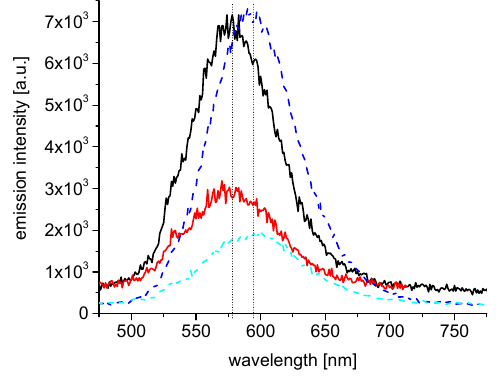
Figure 10. Temperature-dependent solubilization studies of the solvatochromic fluorescent dye HC1 in NSS by the statistical block copolymer PEG- b -P(SPE- co -ZPE)-2: ( — ) = emission at 25 ◦ C in the presence of PEG- b -P(SPE- co -ZPE)-2, ( — ) = emission at 75 ◦ C in the presence of PEG- b -P(SPE- co -ZPE)-2, ( - - - - ) = emission at 25 ◦ C in the absence of PEG- b -P(SPE- co -ZPE)-2 (control 1), ( - - - - ) = emission at 75 ◦ C in the absence of PEG- b -P(SPE- co -ZPE)-2 (control 2).